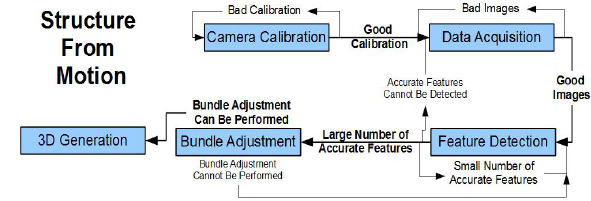
Figure 2: Flow chart of the structure from motion process